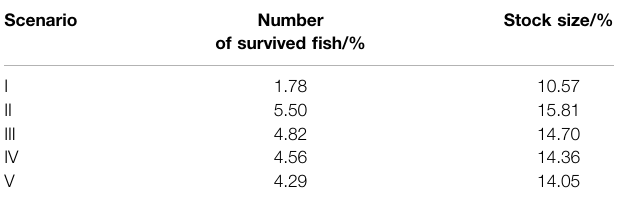
TABLE3| Simulationofpercentagesofthesurvived fi shandstocksizetothetotal amount of fi sh, respectively, 6 months after release fi nished under scenarios I –